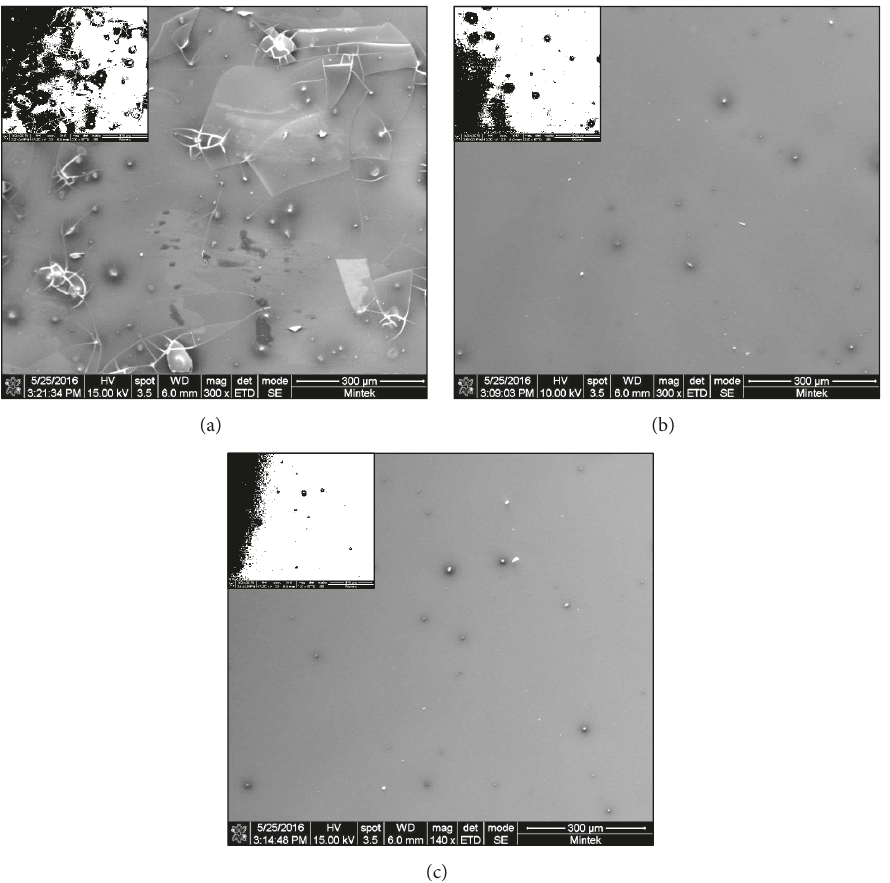
Figure 8: SEM micrographs and their corresponding paint stroke images (attachments) of CdO thin films prepared at 250 (a), 300 (b), and 350 ∘ C